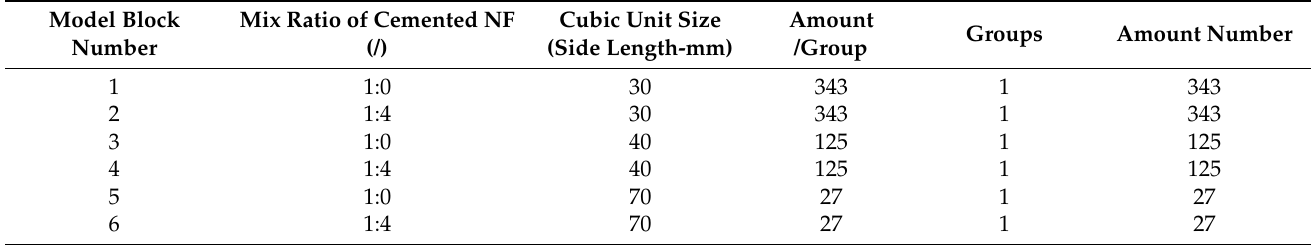
Figure 2. ( a ) Particle grading curve for sand material used for producing the cement blocks and paste interface [19]. ( b ) Uniaxial compressive strength (UCS) of the cubic blocks with sizes of 30, 40, and 70 mm, respectively. Table 1. The experimental design for the hydraulic fracturing